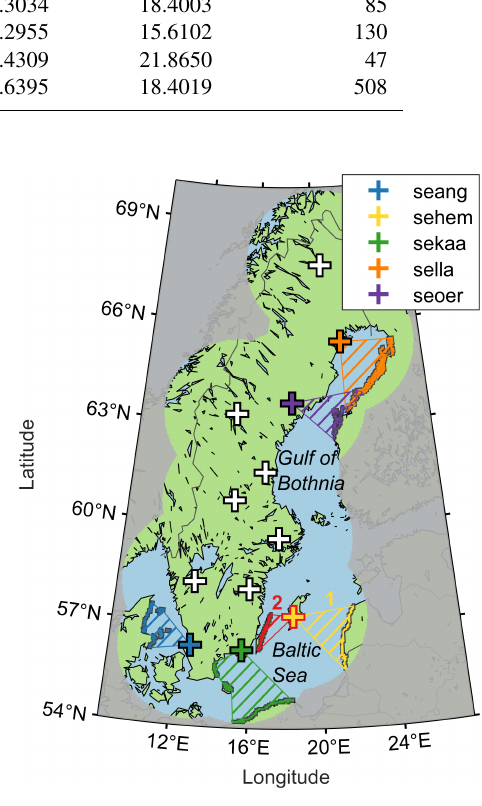
Figure 1. The Swedish weather radar network and its coverage. Radar locations are marked by plus signs. The five radars used in this work are listed in the legend. Six groups of radar cells from these five radars were selected to monitor for ground clutter. These radar cells are shown in different